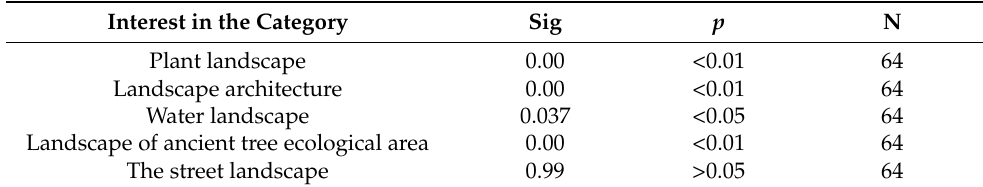
Table 3. Correlative statistics of landscape node interest degree and emotion.